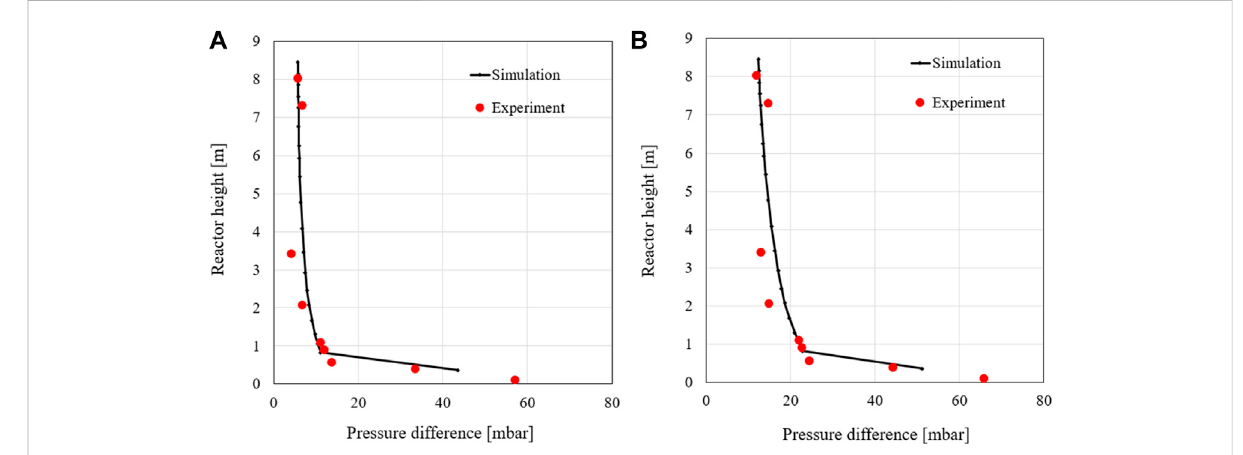
FIGURE 5 Pressure curves of the second load cases: 60% (A) and 100% (B) .